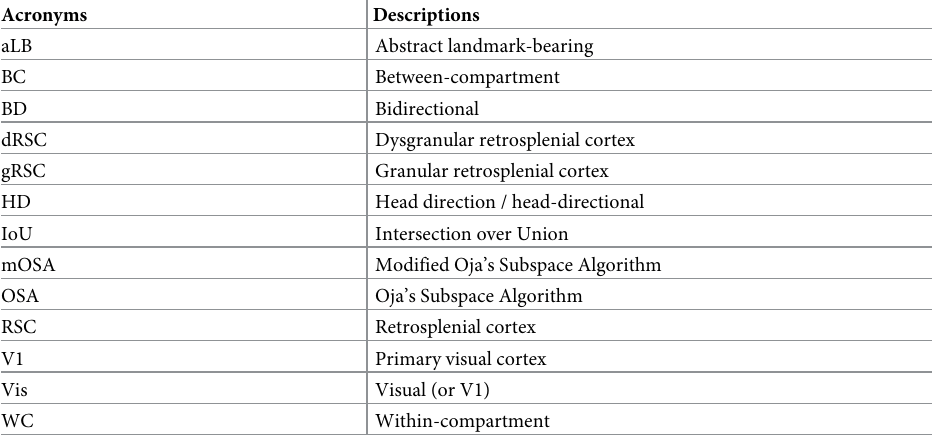
Table 1. The ascending sorted